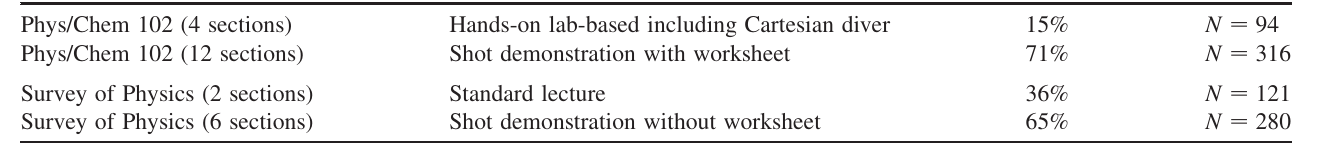
TABLE IV. Percentages of students giving correct answers on the Five Blocks problem after all instruction on density and its connection to sinking and floating, for different course types and instructional interventions. Each row in the table below except the first includes at least two different